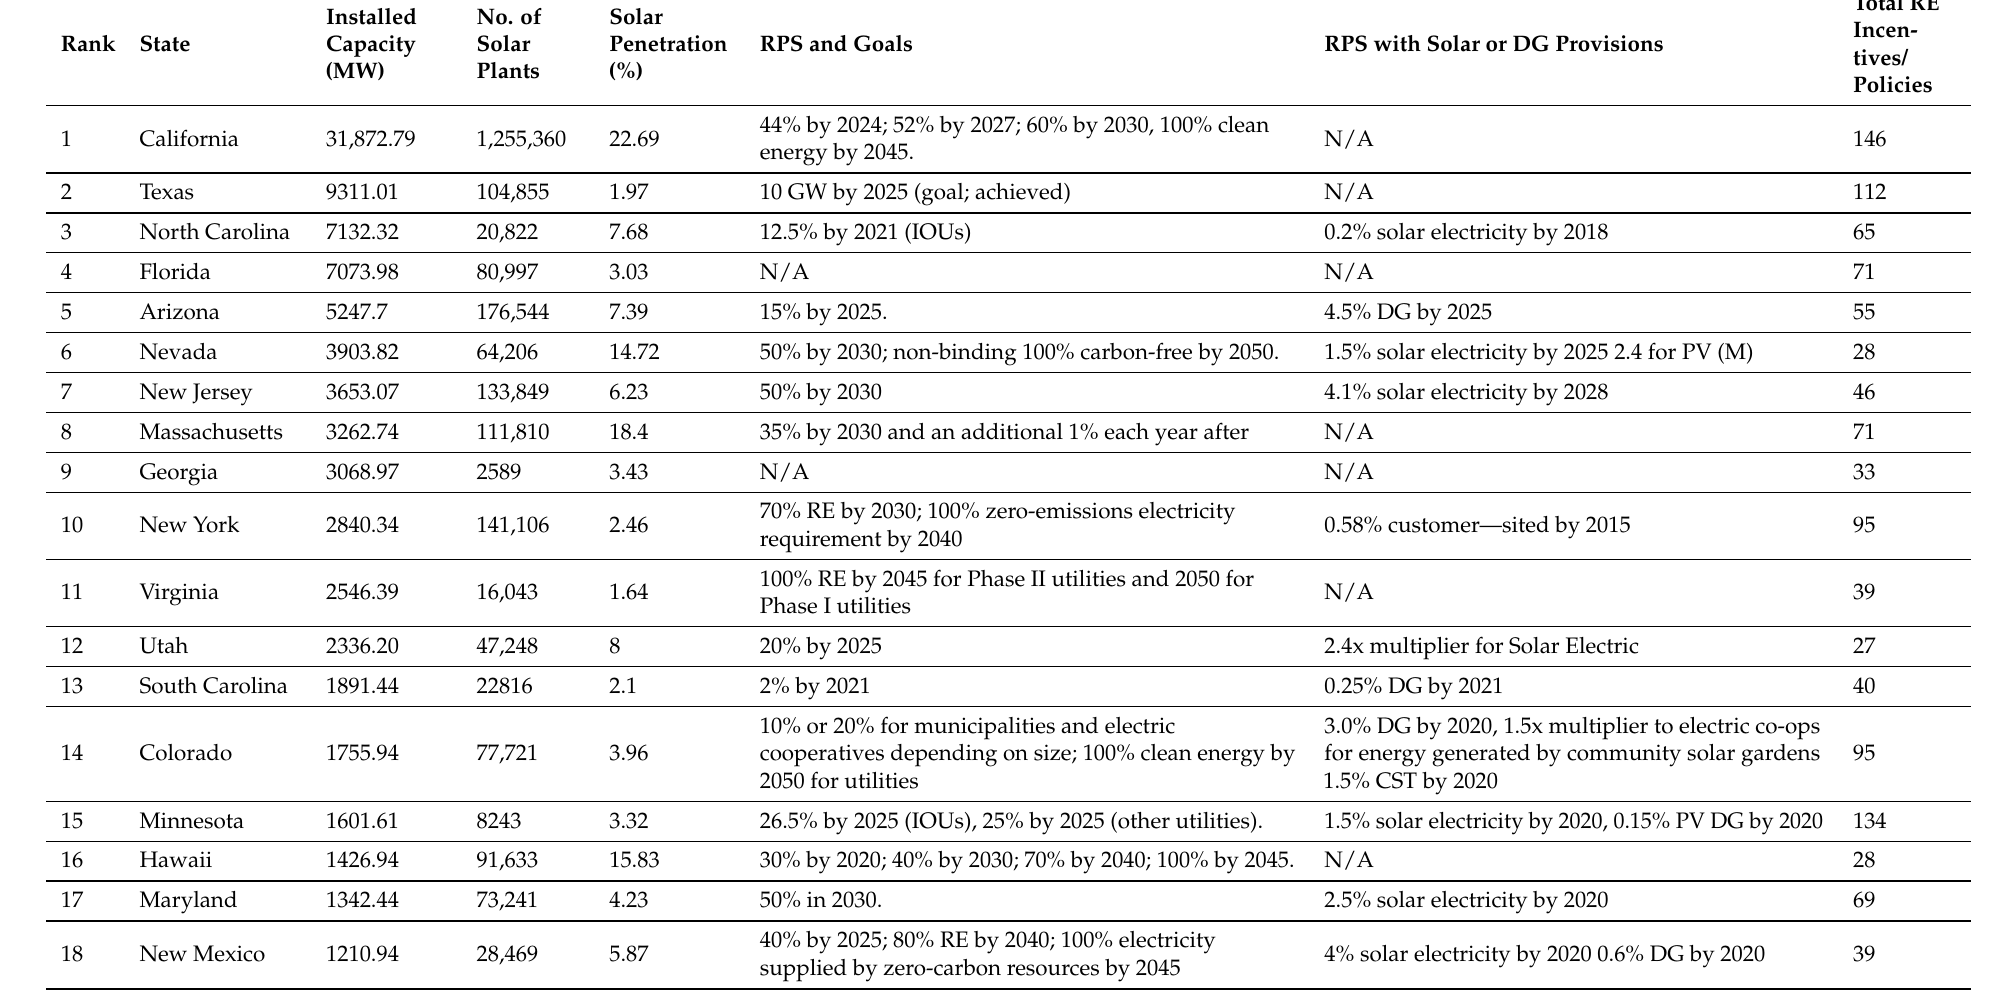
Table 3. State-wise overview of installed solar capacity, goals, and